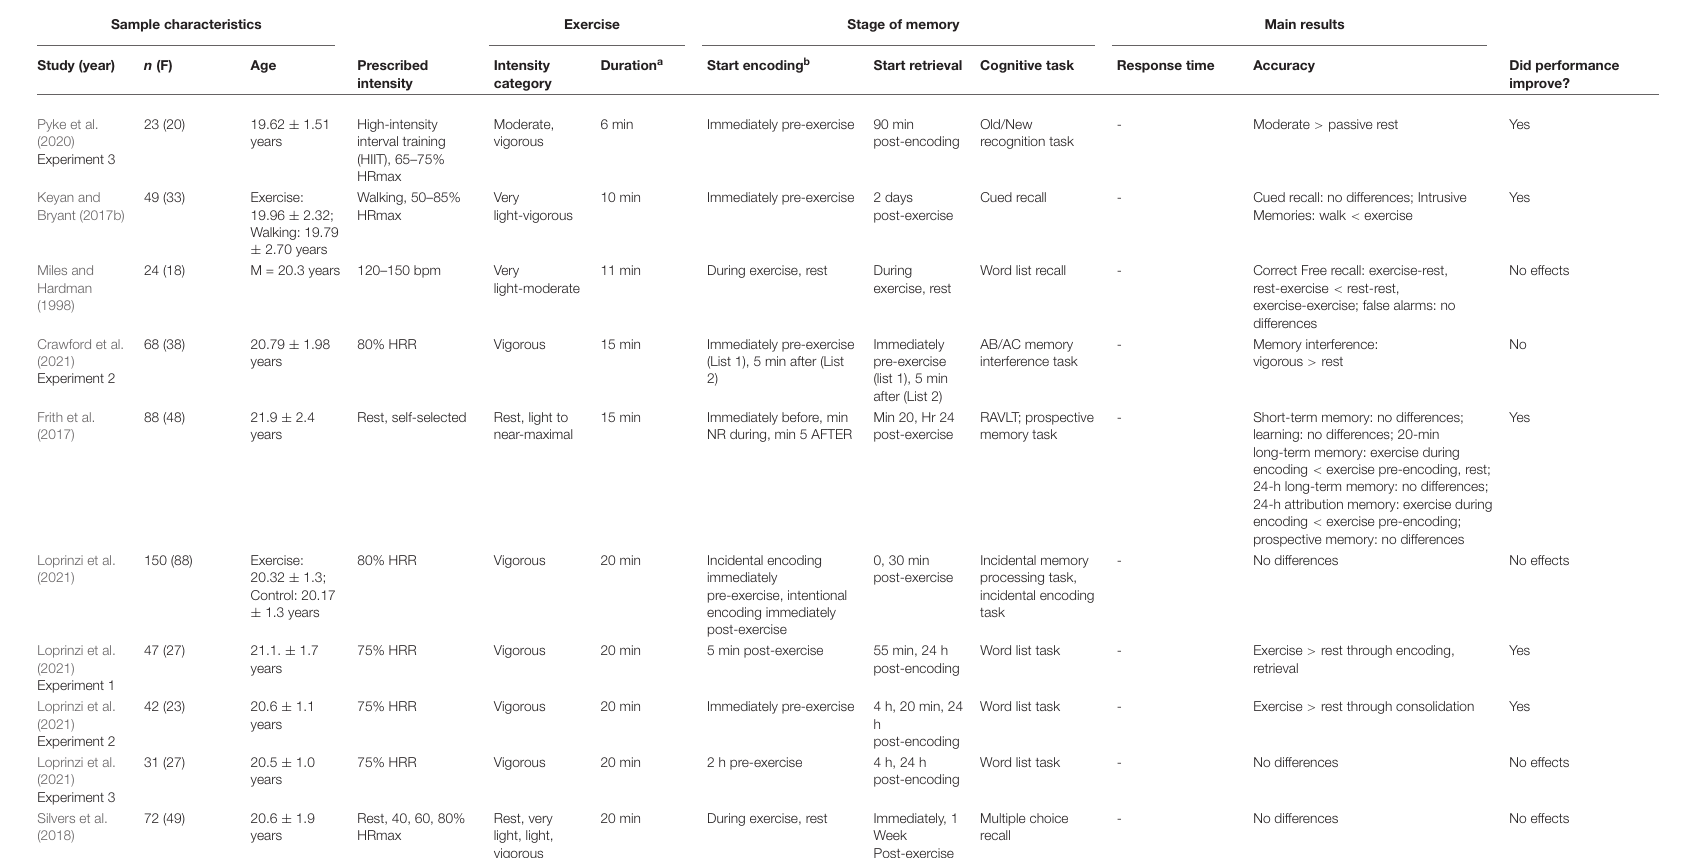
TABLE 7 | Summary of studies examining memory during acute aerobic